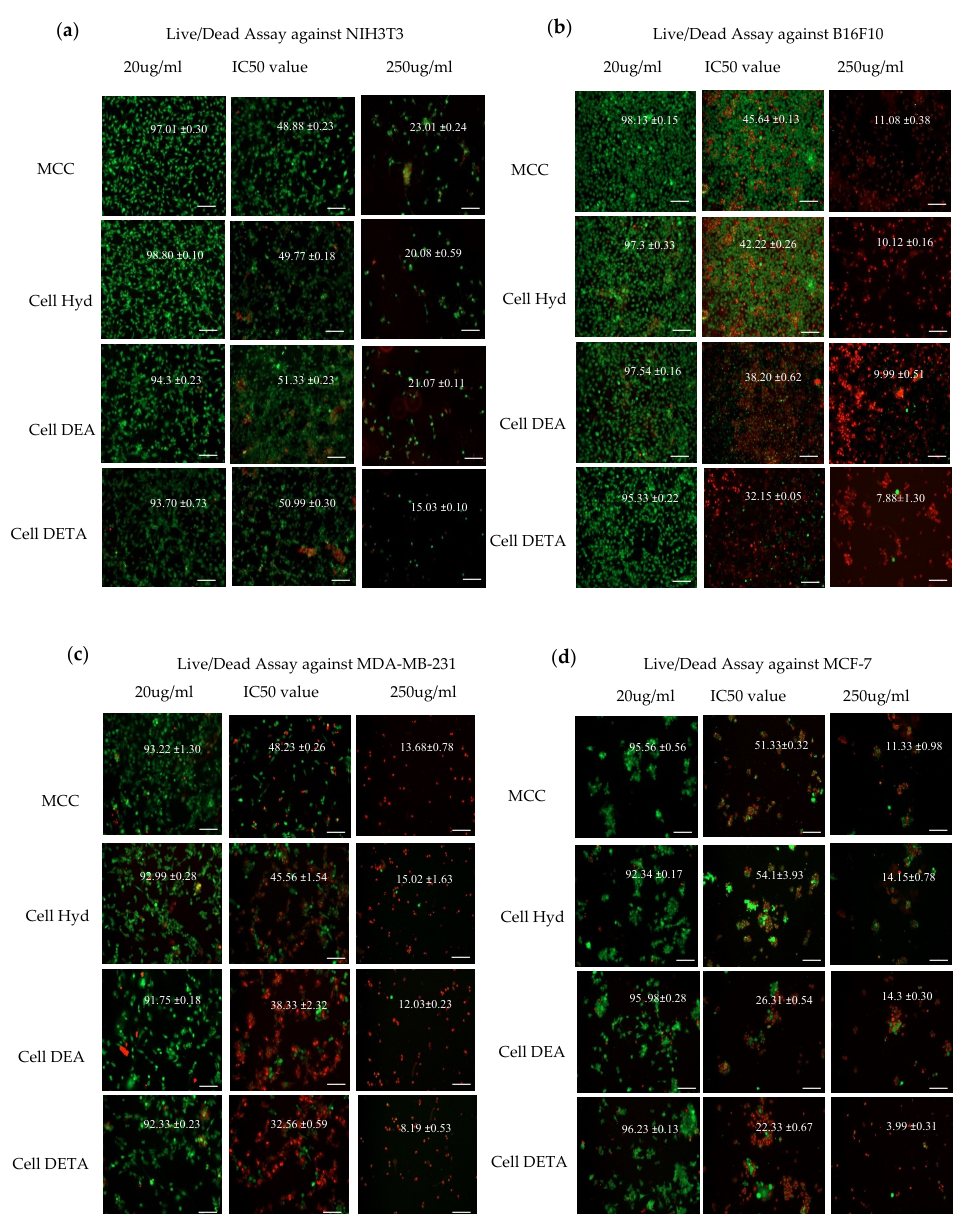
Figure 5. Cell culture live dead assay after treatment with cellulose and its derivatives MCC, Cell Hyd, Cell DEA and Cell DETA, at 3 concentrations after 24 h; against Normal ( a ) NIH3T3 and Cancer cell lines ( b ) B16F10, ( c ) MDA ‐ MB ‐ 231, ( d ) MCF ‐ 7. Live cells show green fluorescence when stained with calcein ‐ AM, while dead cells show red fluorescence stained with ethidium homodifier. Live cell percentage is shown on the images as total percentage of live cells from four random fields with mean ± standard deviation of 3 replicates of samples. Scale bar is 100 μ m.